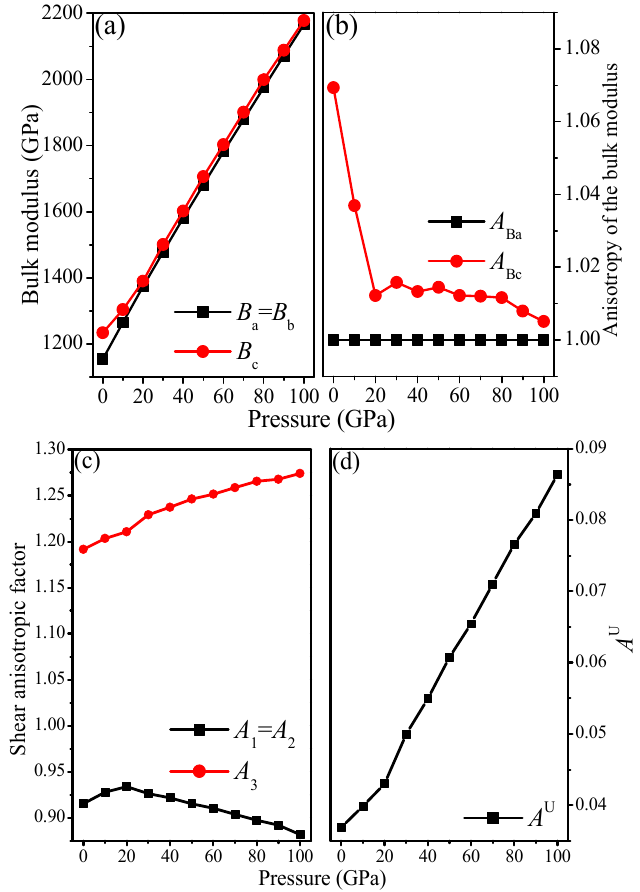
Figure 5. Linear bulk modulus B a , B b , and B c of 4 I –carbon at 0 K as a function of pressure ( a ); anisotropy factors of 4 I –carbon at 0 K as a function of pressure, ( b ) A Bb and A Bc ; ( c ) A 1 , A 2 and A 3 ; ( d ) A U .